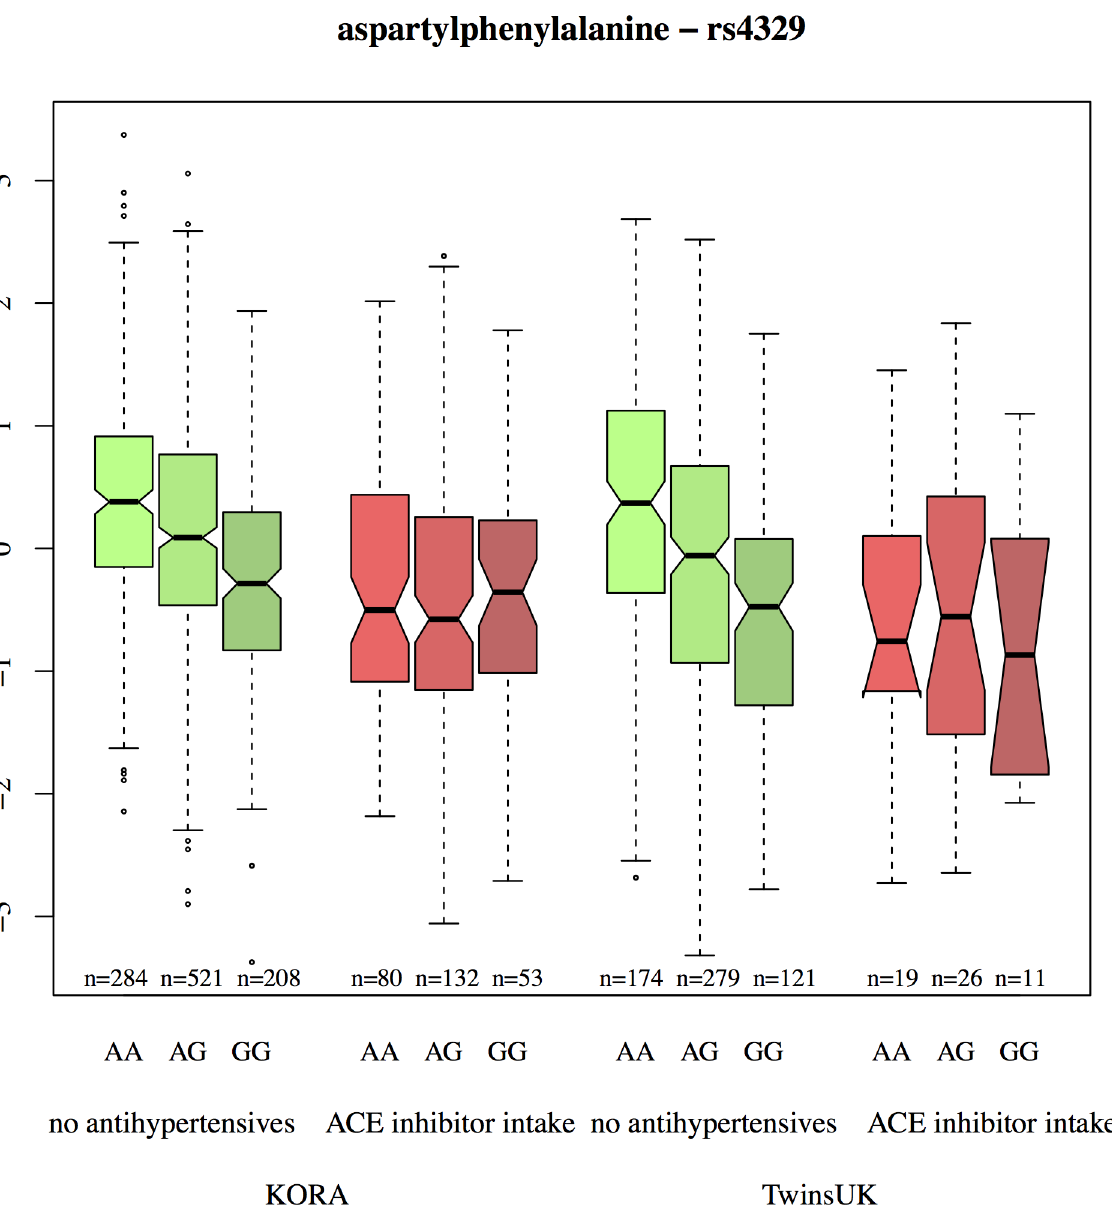
Fig 1. Inverse normalized values of aspartylphenylalanine for KORA and TwinsUK (AA: major homozygotes, AG: heterozygotes, GG minor homozygotes).